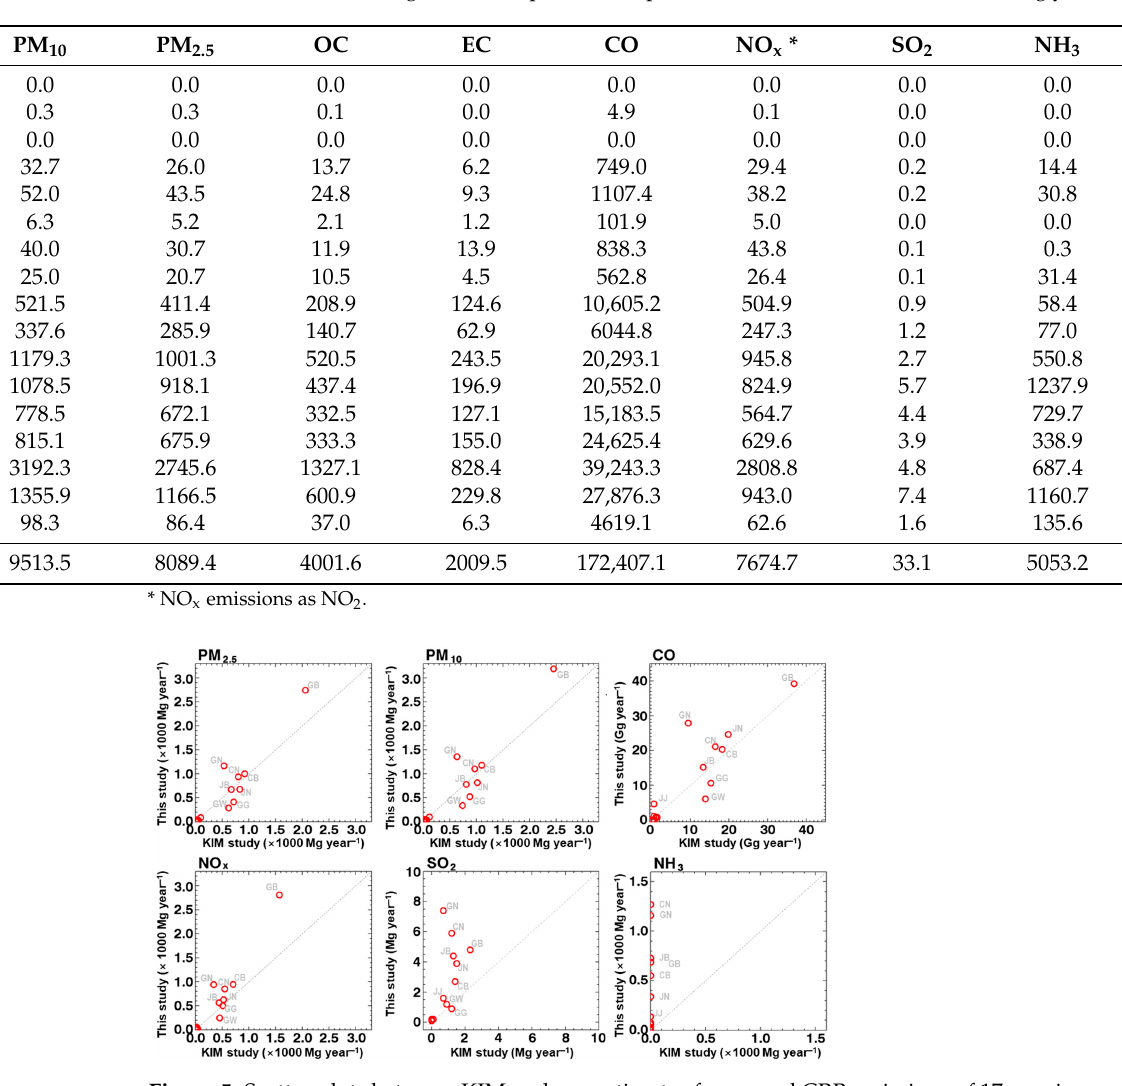
Table 3. CRB emissions of gaseous and particulate species estimated in South Korea (unit: Mg year − 1 ).